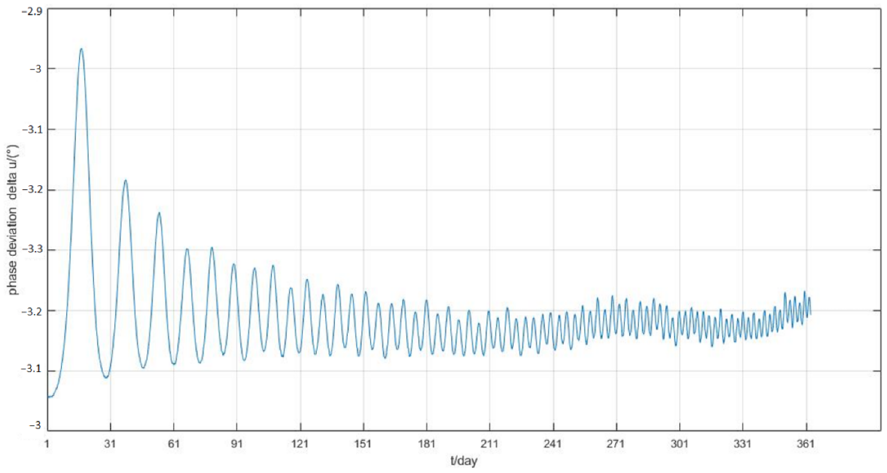
Figure 15. Phase deviation of two satellites.